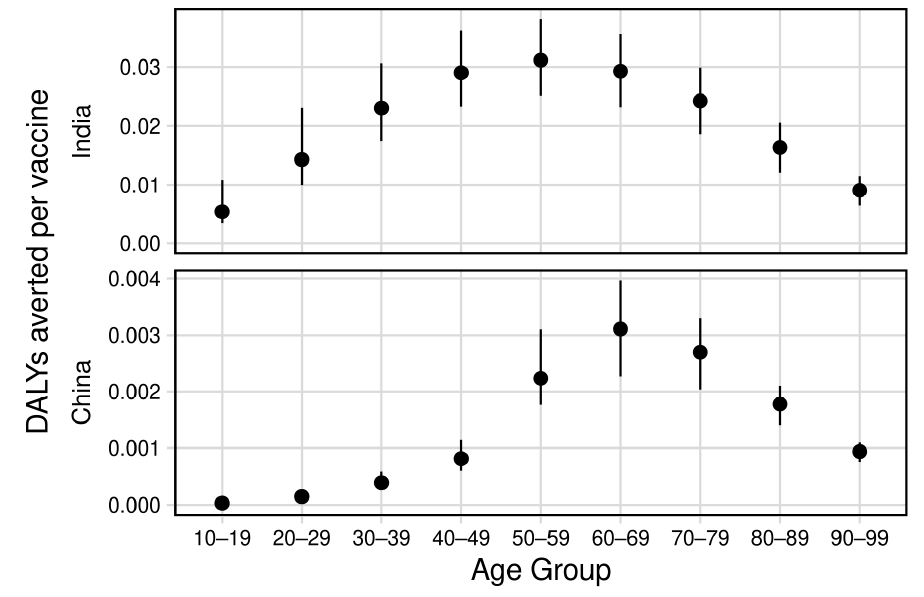
Figure 3. Vaccination efficiency by target age group. Efficiency is defined as the number of DALYs averted per vaccine delivered. Mass vaccine campaigns were deployed at 70% coverage to each age group.